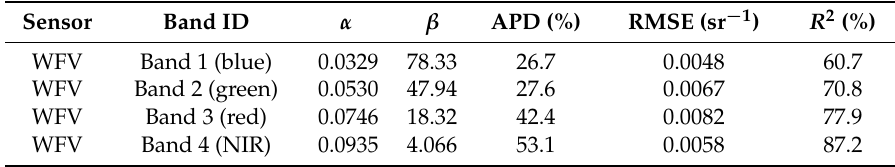
Table 3. α and β values of WFV camera at each band, derived from the non-linear regression shown in Figure 2. The absolute percentage difference (APD), root mean square error (RMSE), and determination coefficient ( R 2 ) of the regression at each band is also listed.